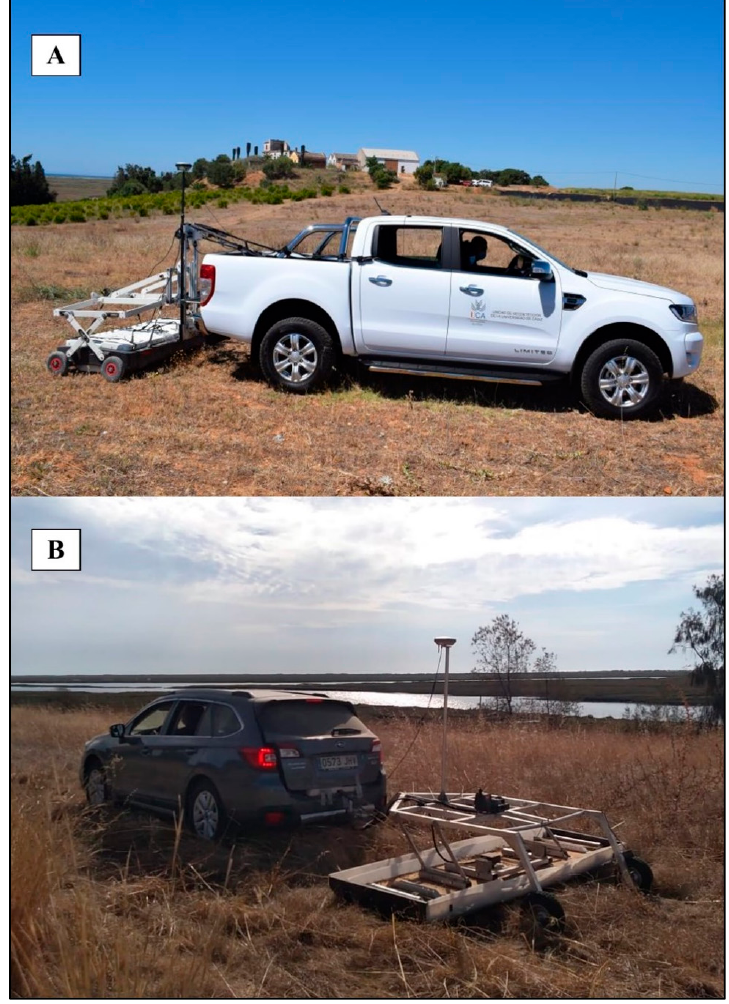
Figure 3. The GPR equipment used: ( A ) GPR Stream X; ( B ) GPR MkIV.